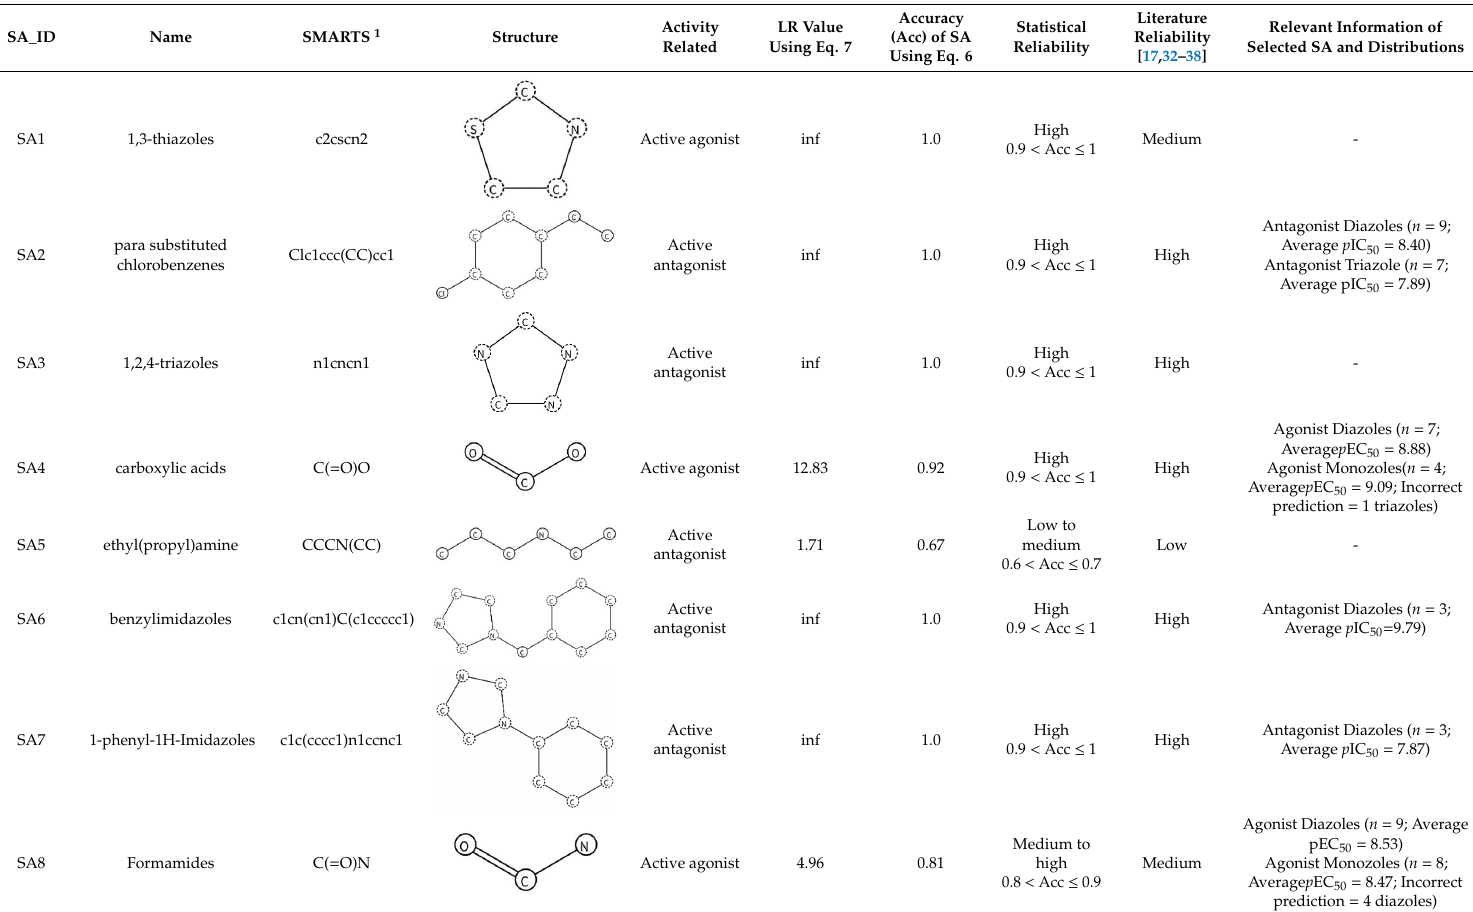
Table 1. Structural fragments for agonist and antagonist activity on CYP19A1 obtained from classification modeling along with their statistical parameters.